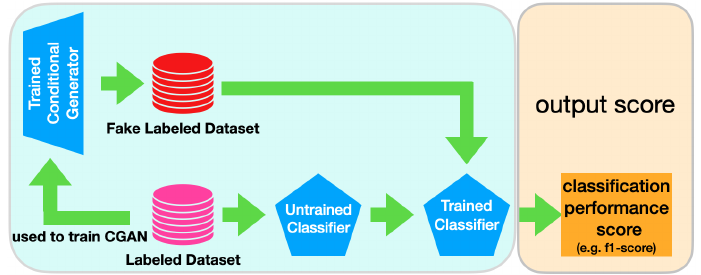
Figure 2. The architecture of an oracle instance based on CAS-syn